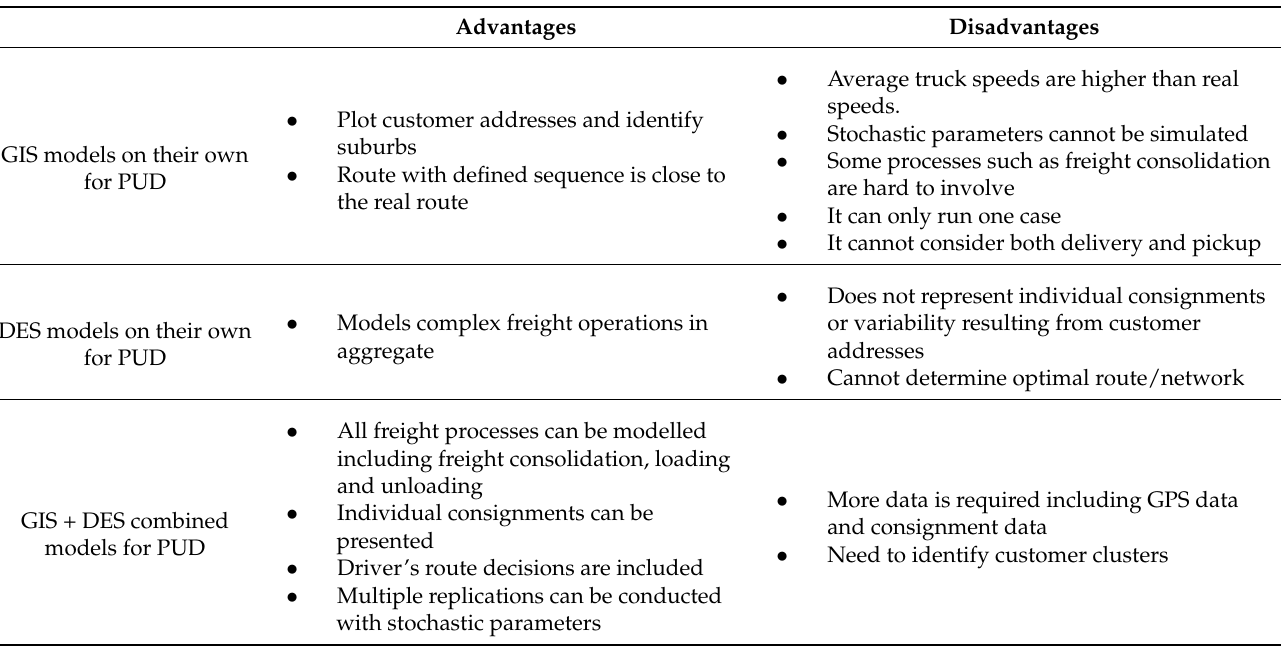
Table 7. Comparison of GIS models and GIS + DES models for